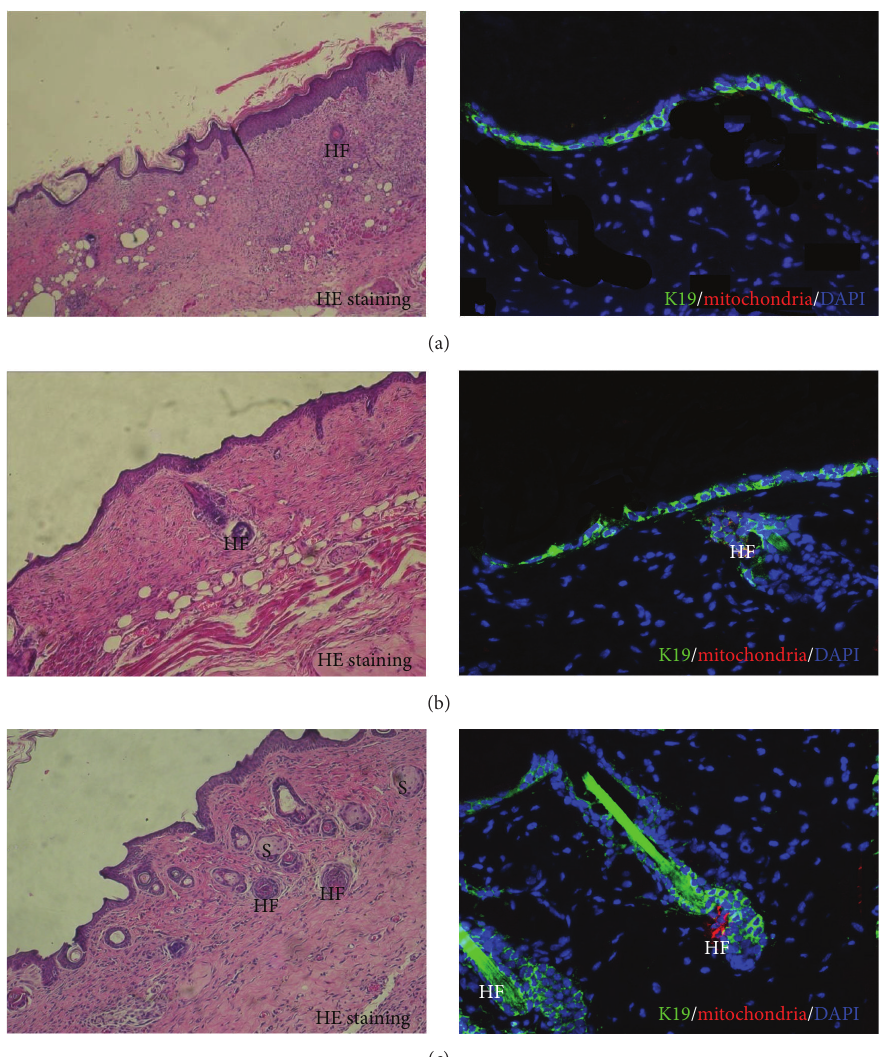
Figure 3: HE staining showed that, at day 28, a lot of typical hair follicle-like structures appeared in ADMSC-AAM seeding group (c) com- pared with hAM group (a) and AAM group (b). Immunohistochemistry showed that the healed epidermis was positive for cytokeratin 19. Some cells of new hair follicles were positive for both keratin 19 (green) and human derived mitochondria (red). S: sebaceous; HF: hair follicle.